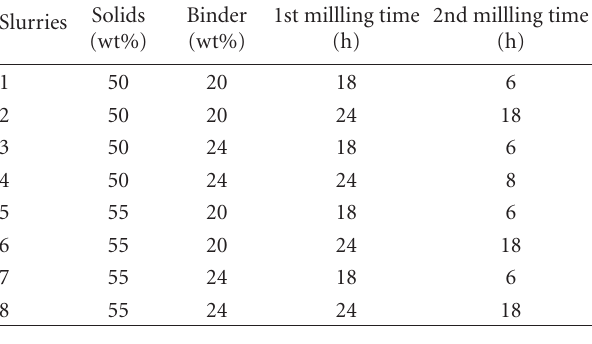
Table 1: Design of experiments (DOE) for optimization of slurries. Slurries Solids (wt%)